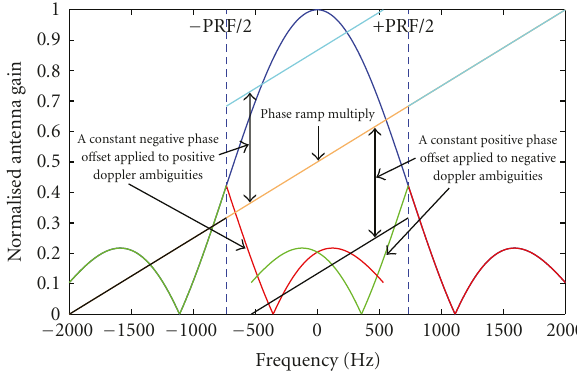
Figure 3: Illustrating the interpolation (or time shift) of an ambiguous clutter signal via the application of a frequency phase